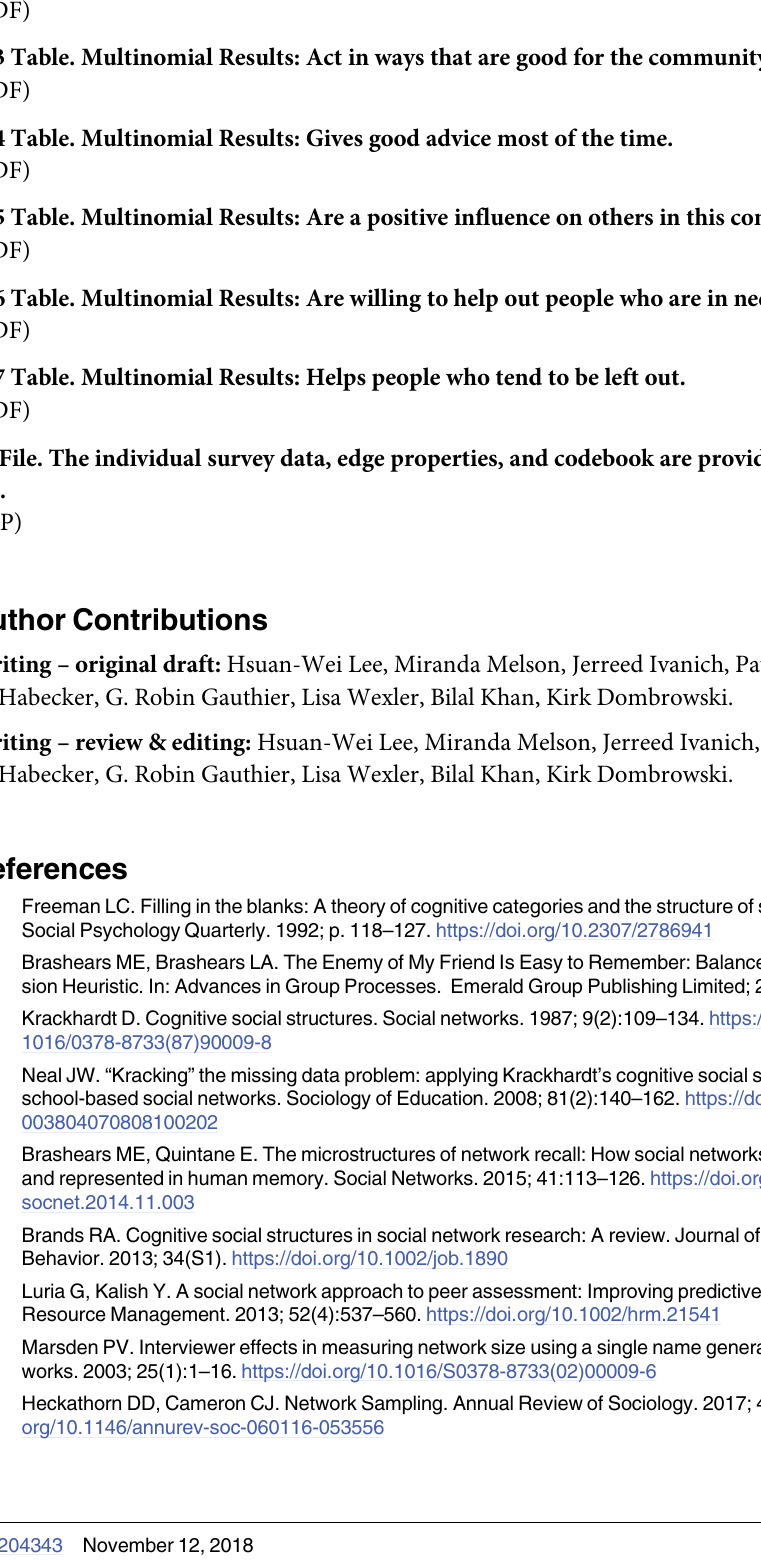
S11 Table. Multinomial Results: Will correct a young person if he or she is doing some- thing wrong. S12 Table. Multinomial Results: Is a member of a respected family. S13 Table. Multinomial Results: Act in ways that are good for the community. S14 Table. Multinomial Results: Gives good advice most of the time. S15 Table. Multinomial Results: Are a positive influence on others in this community. S16 Table. Multinomial Results: Are willing to help out people who are in need. S17 Table. Multinomial Results: Helps people who tend to be left